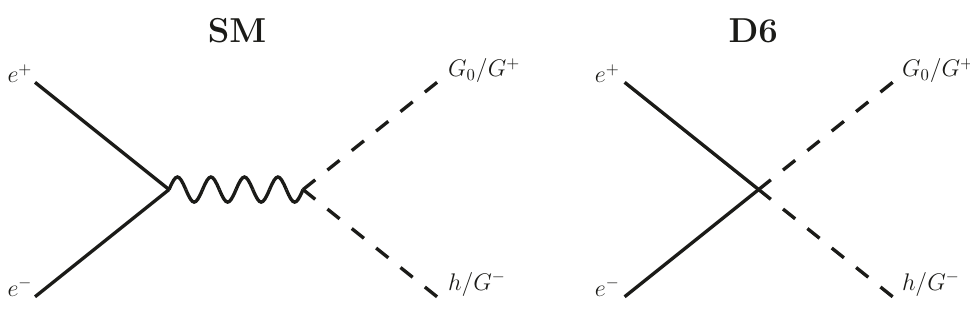
Figure 1. The leading high energy contribution to e + e − → Zh, W + W − amplitudes in the SM and D6 SMEFT using the Goldstone Boson Equivalence